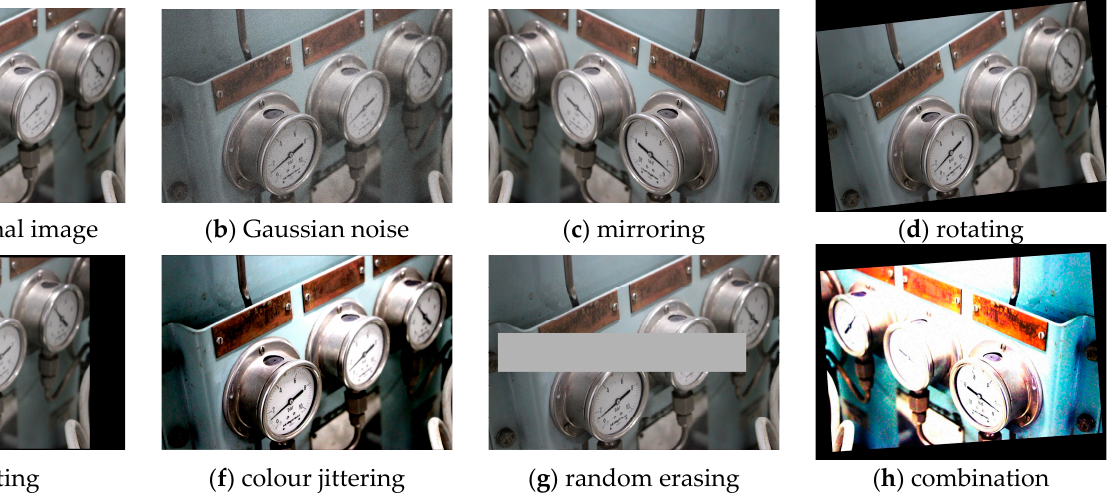
Figure 15. Examples of data augmentation.